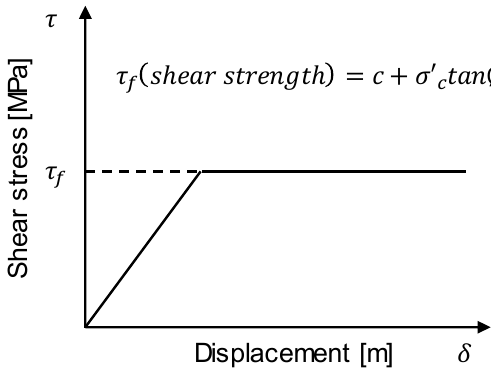
Figure 6 . Comparison of interface stiffness models Figure 6. Comparison of interface sti ff ness